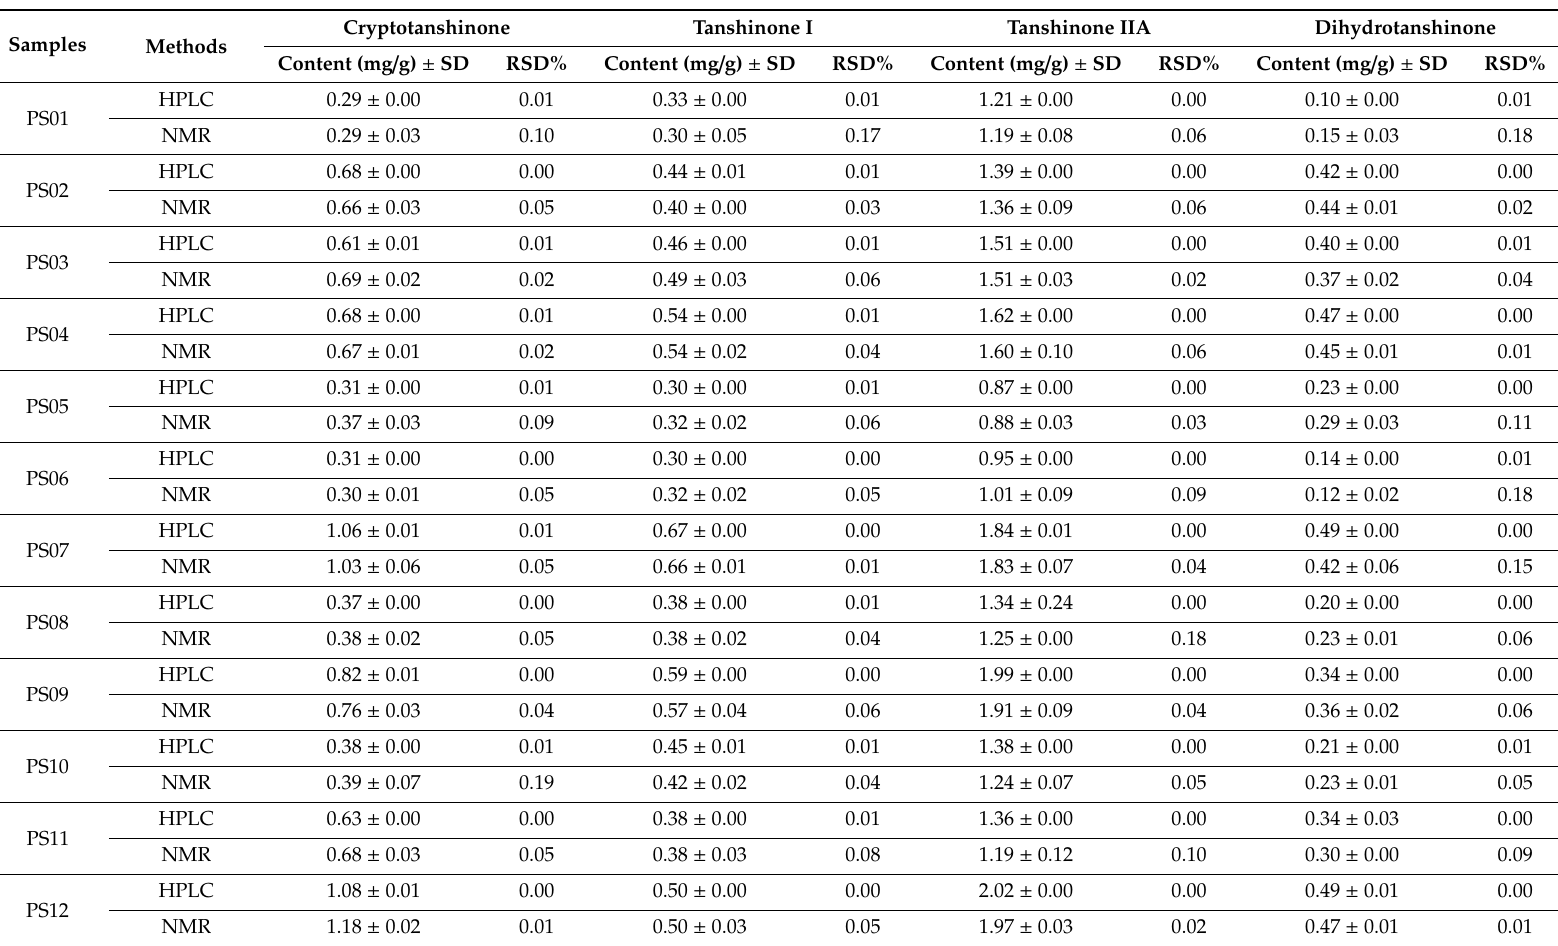
Table 6. Assay (%) of four lipid-soluble ketones acid in the 12 di ff erent origins crude extract of SMB determined by the 1H NMR and HPLC methods.